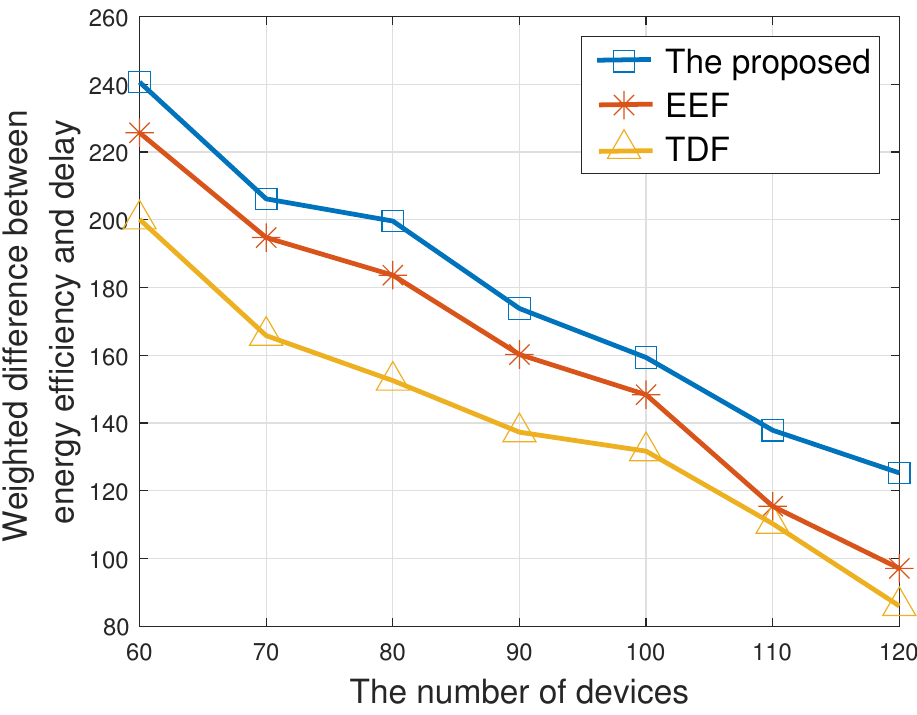
Figure 2. Weighted difference between energy efficiency and delay versus the number of devices.